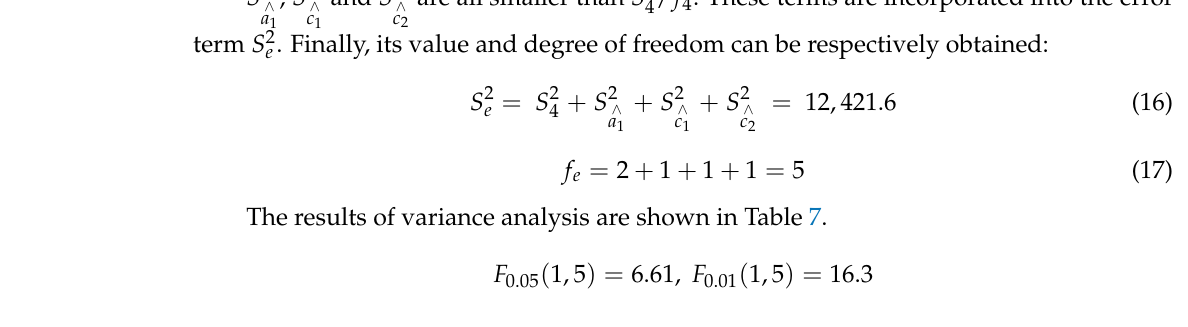
Table 7. The analysis of